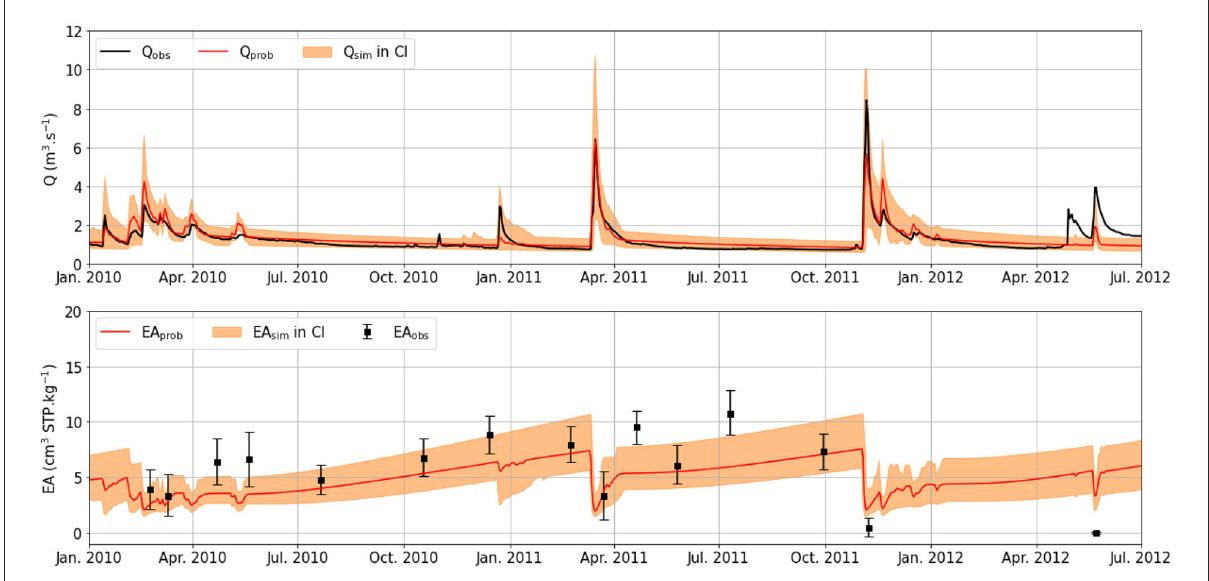
FIGURE6 Observed and simulated time series in the confidence interval (CI) with the 0.1% proportion out of 50,000 simulations within the parameter space sampled with the Latin Hypercube Sampling (LHS) procedure: (top) spring discharge Q and (bottom) spring air excess EA. Q prob and EA prob consists of the weighted mean of the simulation in the confidence interval. The weight corresponds to the objective function 8 such as the lower the prediction errors the higher the